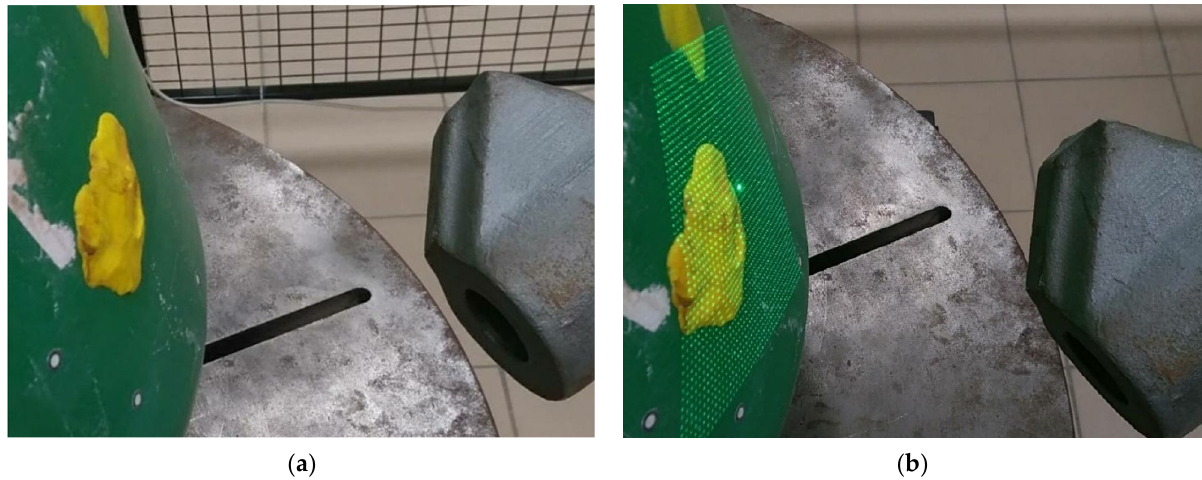
Figure 17. ( a ) Example for setting the pick holder ( b ) with projected laser grid of points.